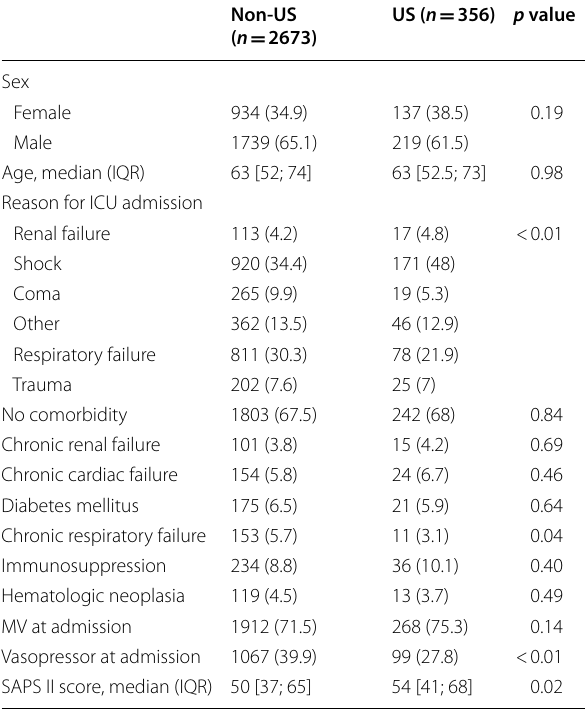
Table 1 Patients’